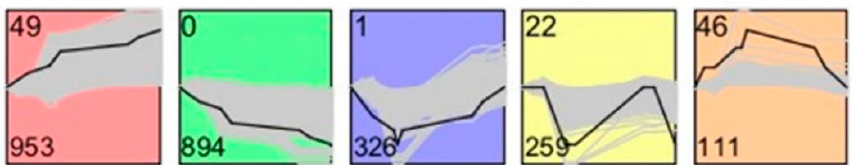
Figure 4. Five profiles of DEGs with unique expression alterations over SSCs, M and R. The profile number is shown at the top left corner of each square. The number of genes grouped in each profile is shown at the bottom left corner of each square. Profiles are ordered based on the number of genes assigned.